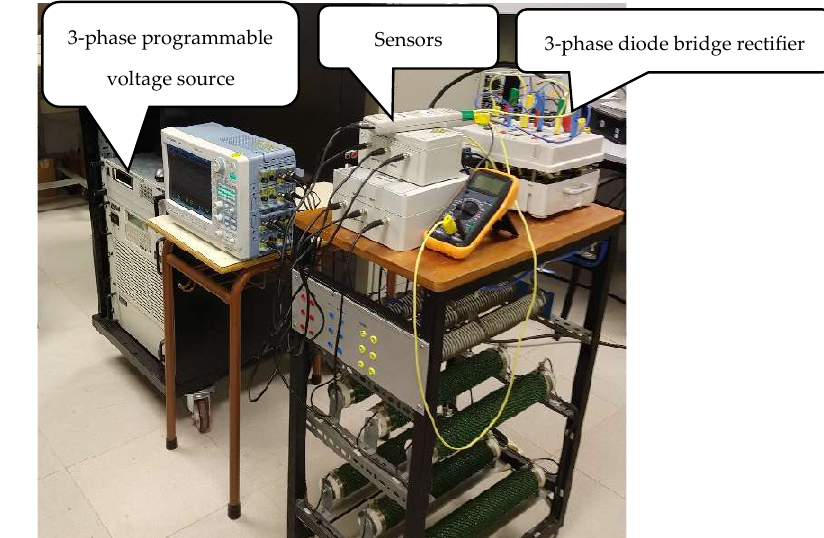
Figure 6. Experimental setup used to validate the proposed methodology.